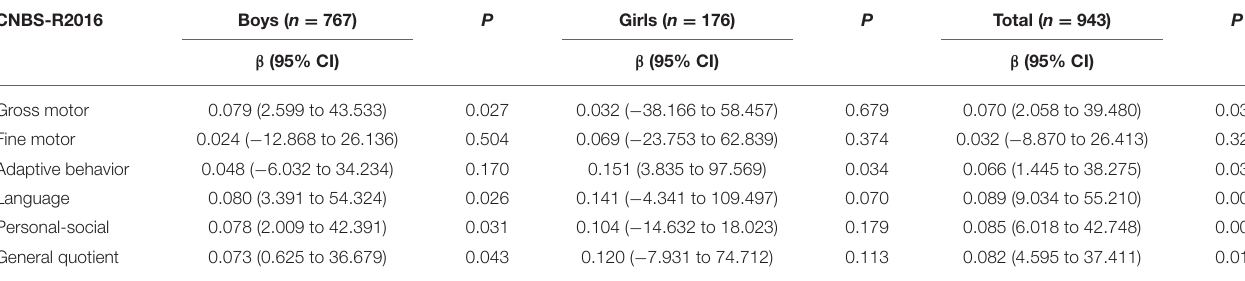
TABLE 5 | Effect of serum VA level on the scores of CBNS-R2016 in the ASD children at different gender groups.